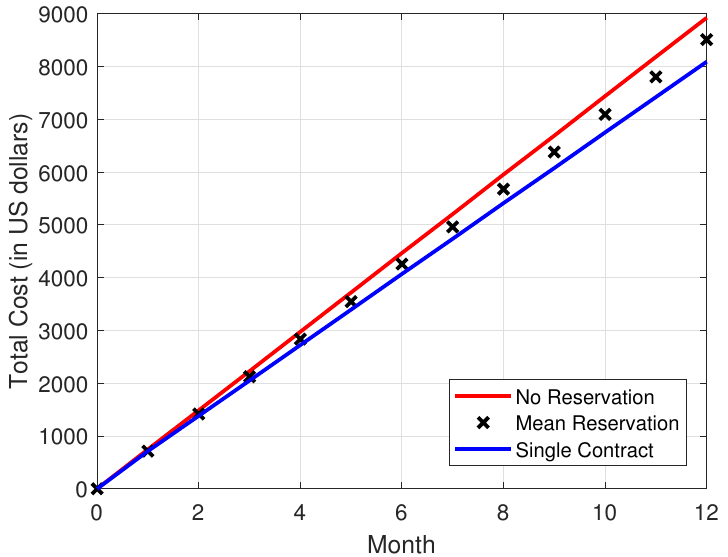
Figure 10. Total cost vs. month. The demand traffic is modeled as a Poisson stochastic process with mean = 4000 VMs. Monthly cost (in USD).